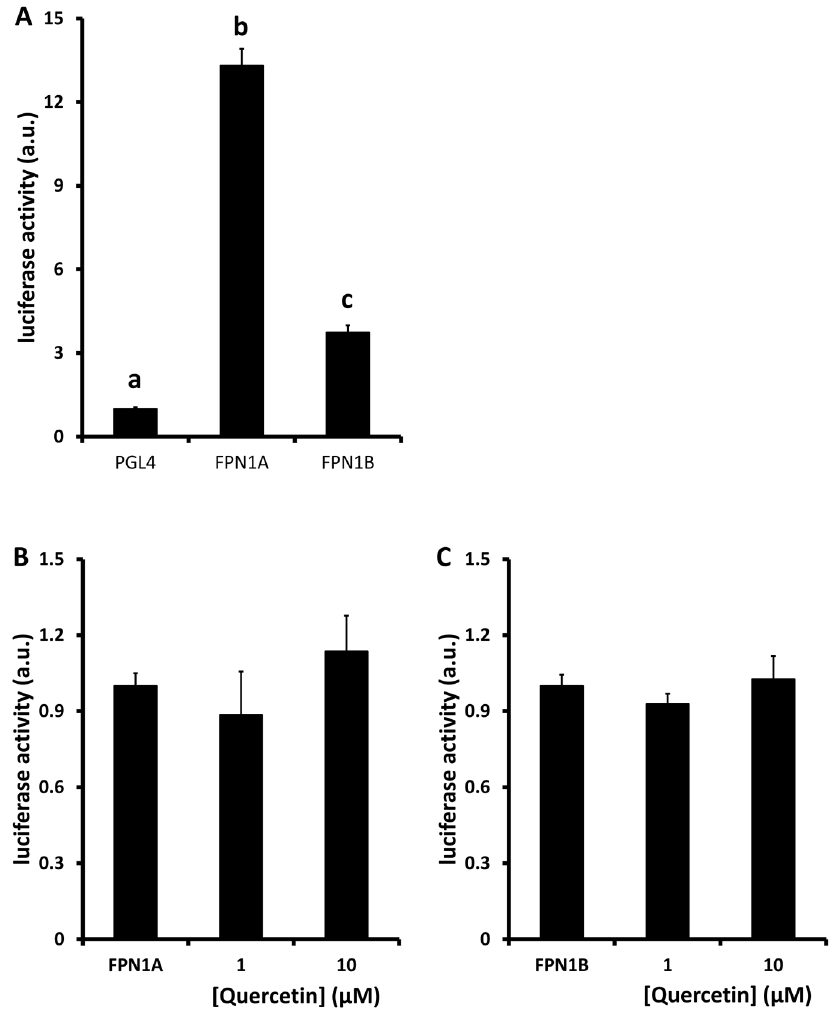
Figure 5. Effects of quercetin on FPN promoter activity. Caco-2 cells were transfected with luciferase reporter constructs containing 1Kb of either FPN1A or FPN1B 5 9 promoter, or with the empty PGL4 plasmid. Luciferase activity (normalised to renilla) arising from basal activity of the promoters (A) and following exposure to quercetin (1 or 10 m M) for 18 h (B) was measured using the Dual Luciferase Reporter Assay (Promega). Data are mean 6 SEM of 6-9 observations in each group. Groups with no common letters are significantly different from each other (one-way ANOVA and Tukey’s post hoc test; P , 0.05). No letters indicates no significant difference between any of the groups.